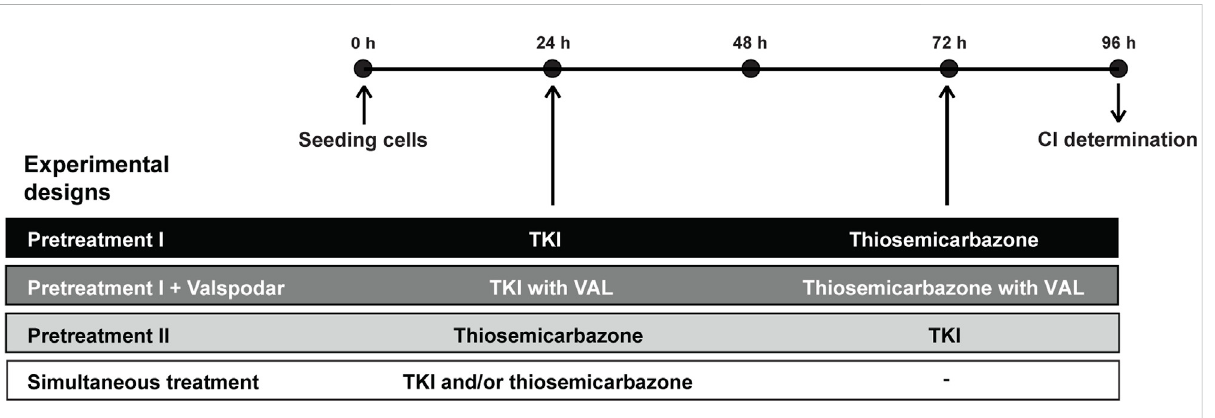
FIGURE 1 Experimentaldesigns andtimelineofcombinedtreatmentsused toevaluate theinteractions between thiosemicarbazones(Dp44mTandDpC) and TKIs (SUN, GEF, and LAP). According to sequential treatment designs with various pretreatments, the cells were seeded, and the following compounds were added: a TKI (Pretreatment I), a TKI with 0.2 Valspodar (VAL; Pretreatment I + VAL), or a thiosemicarbazone (Pretreatment II). 48 h later,anotherdrugwasaddedtotheassay:athiosemicarbazone(PretreatmentI),athiosemicarbazonewith0.2VAL(PretreatmentI+VAL),ora TKI (Pretreatment II). In the case of Simultaneous treatment, both a thiosemicarbazone and a TKI were added together. At the end of the tests, the drug interactions were assessed as a combination index (CI). Drug concentrations used to determine CIs in the individual treatment designs were derived from the respective IC 50 values listed in Table 2 (for detailed methodology, see Materials and Methods Section 2.5 and Section